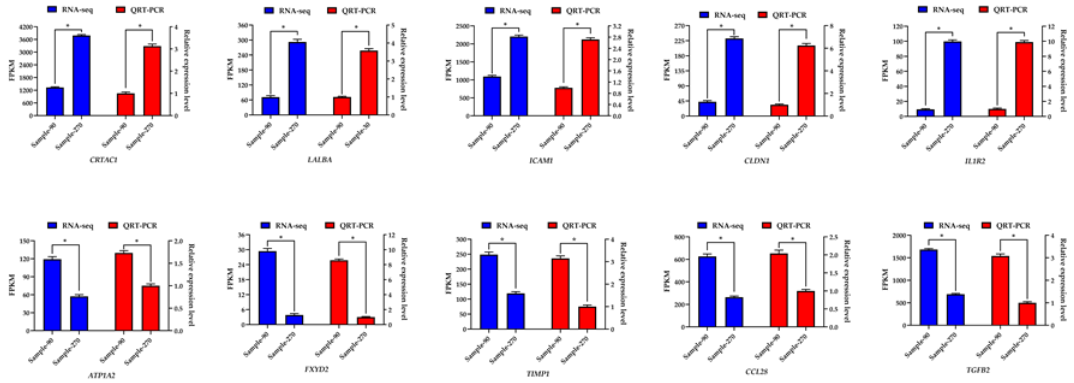
Figure 6. Expression level of ten differentially expressed genes detected by qRT-PCR using β-actin as reference gene and RNA-Seq. “*”: p < 0.05.